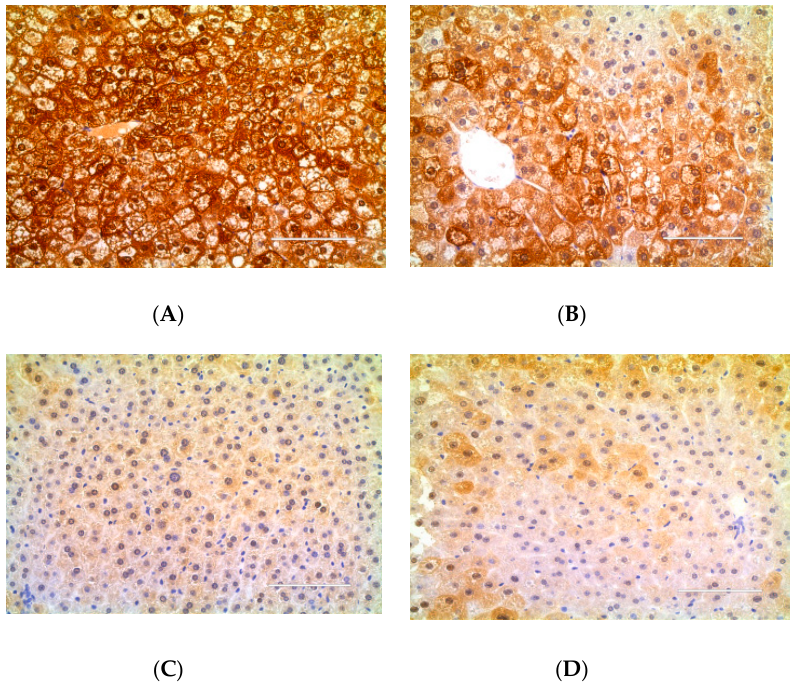
Figure 6. Expression of tumor necrosis factor- α (TNF- α ) in the liver tissue detected by immunohistochemistry. The positive expressive areas of TNF- α are tan. ( A ) DM group; ( B ) DMMET130 group; ( C ) Control group; ( D ) DMDJP100 group.